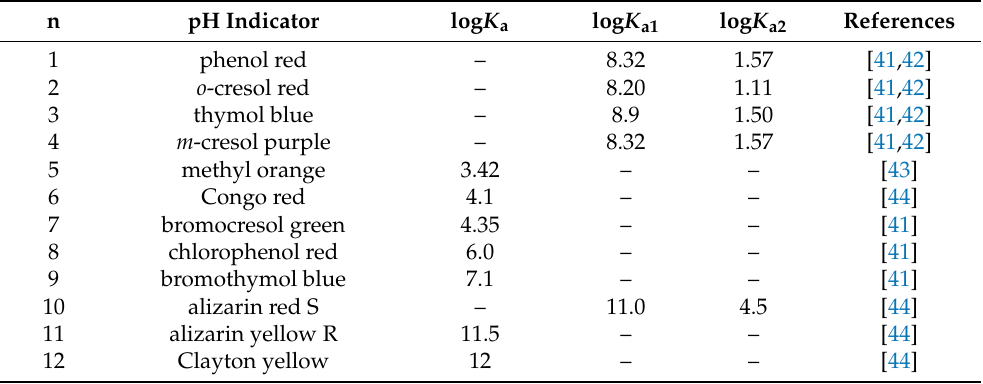
Table 1. pH indicators selected for the chemometric-assisted litmus test (CLT), corresponding log K a values, and bibliographic